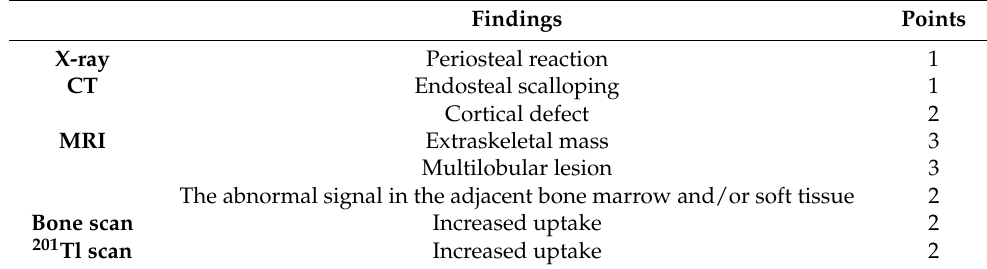
Table 4. Overall radiological scoring system for differentiation between enchondroma and